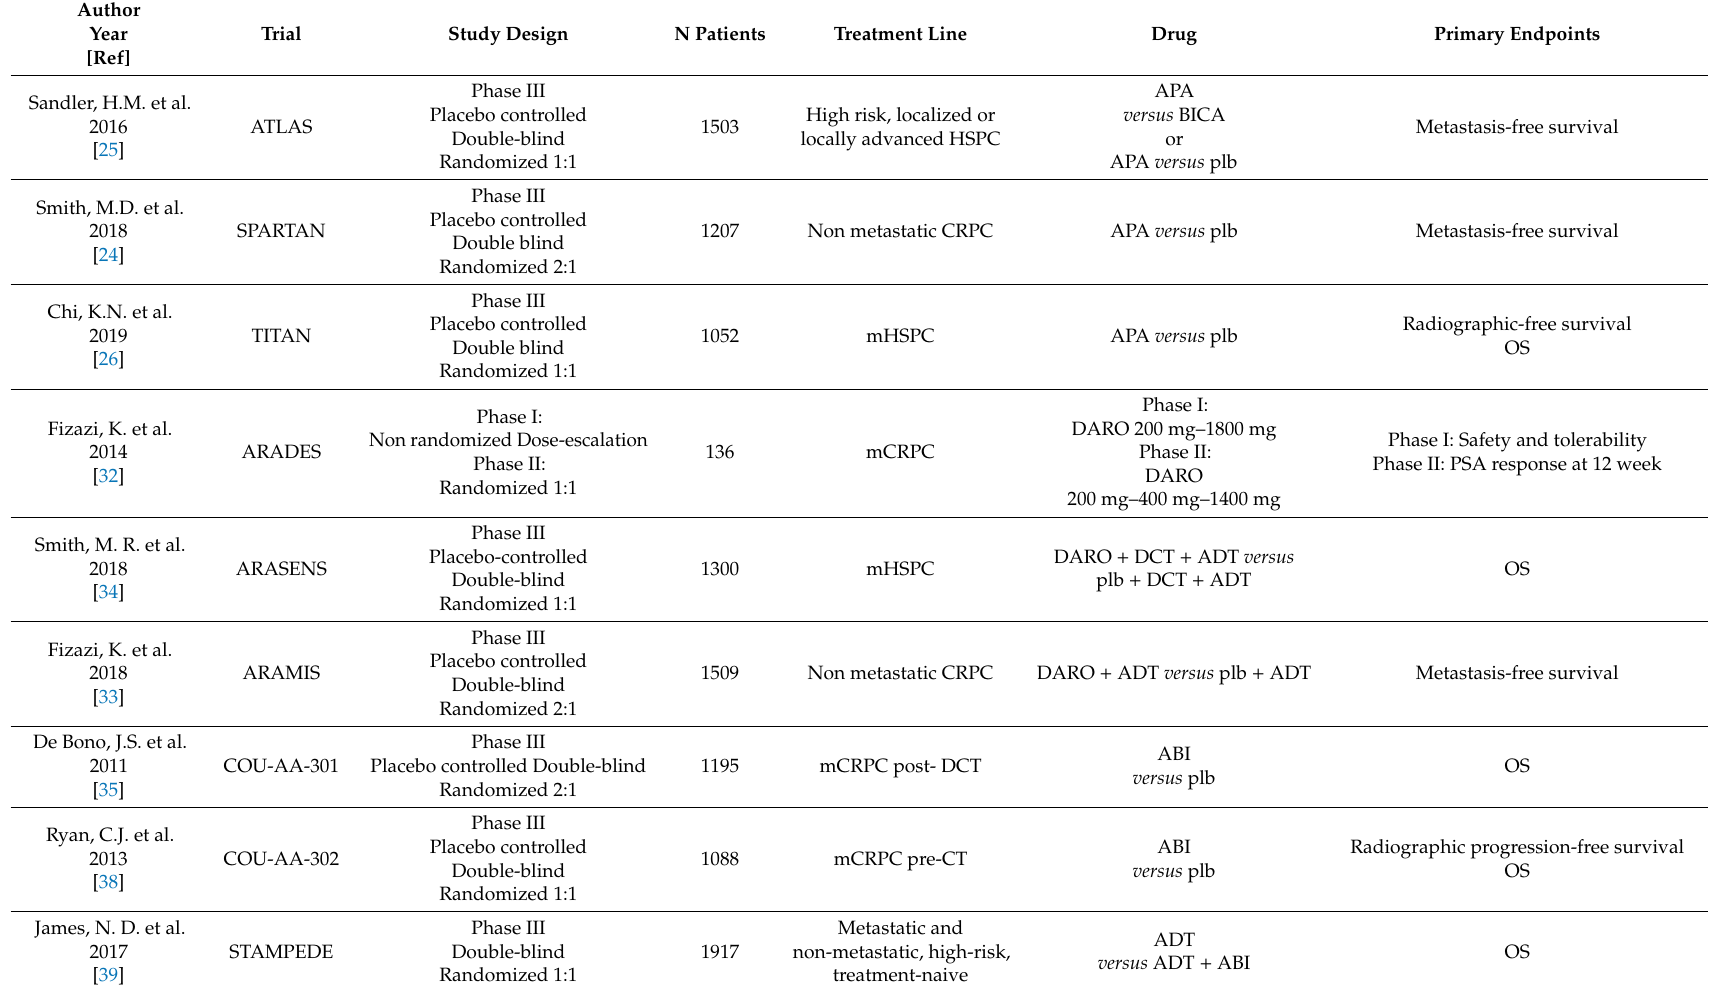
Table 1. Clinical trial involving new drugs for the treatment of advance prostate